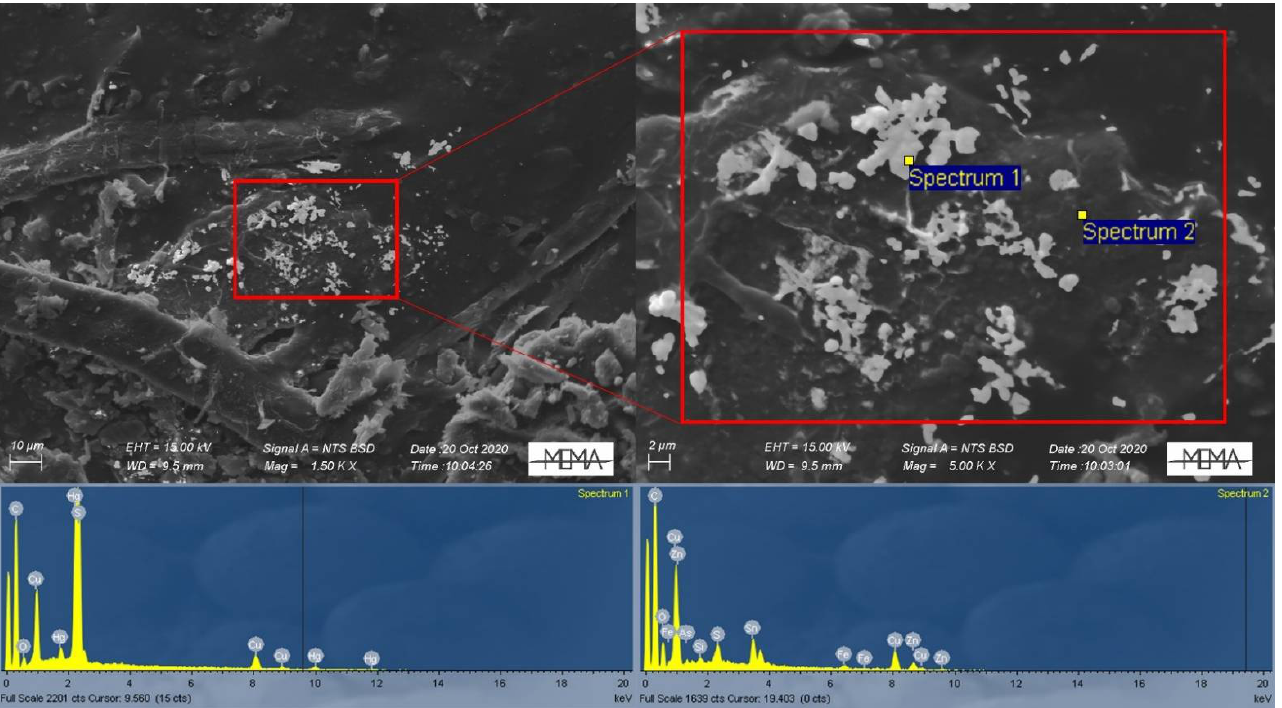
Figure 6 . Detailed analysis of elemental composition of Hg particle clusters found in the 2020 W-AD (Spectrum 1) and of the area surrounding the Hg particles (Spectrum 2).